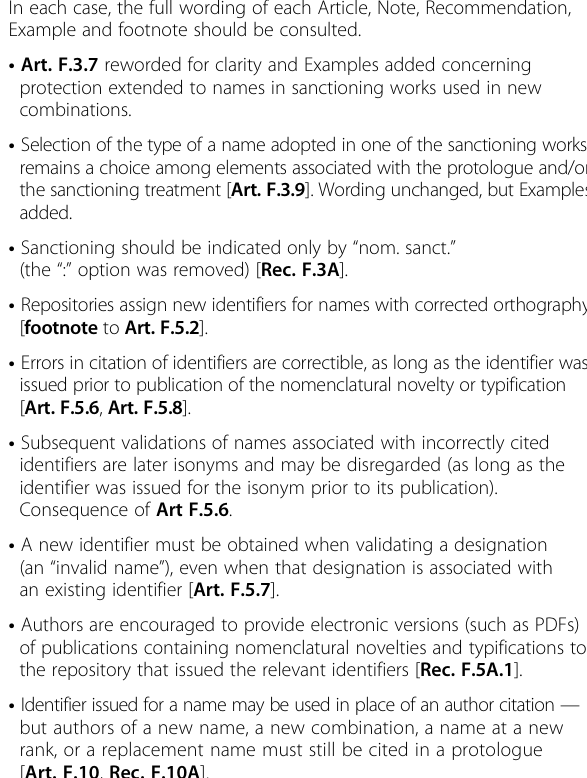
Table 2 Summary of changes incorporated in the San Juan Chapter